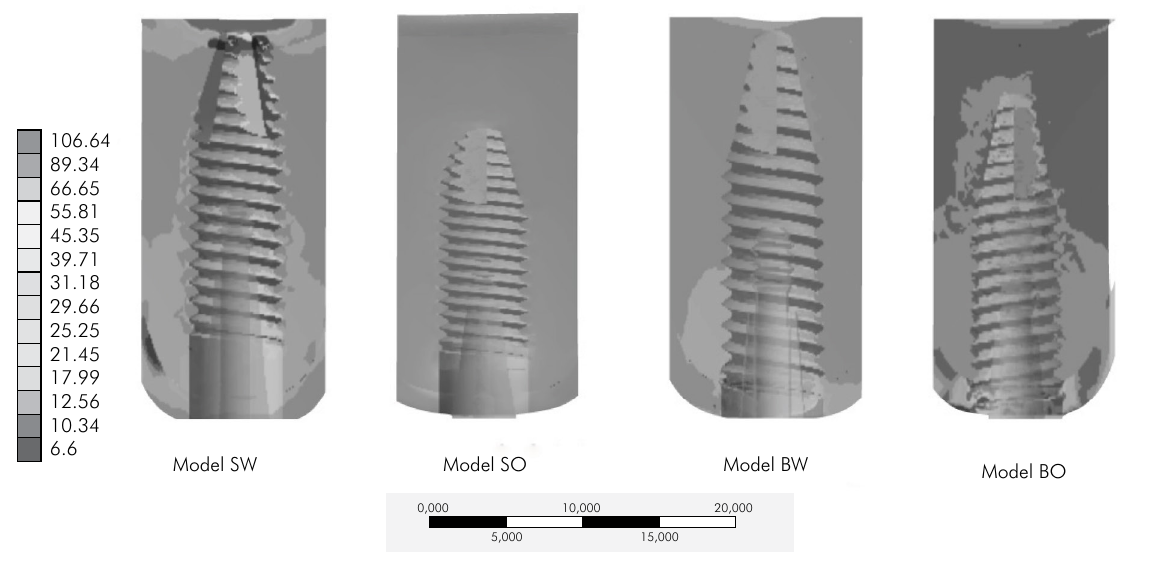
Figure 2. Compressive stress (MPa) around implants with different anchorage designs under centric loading.